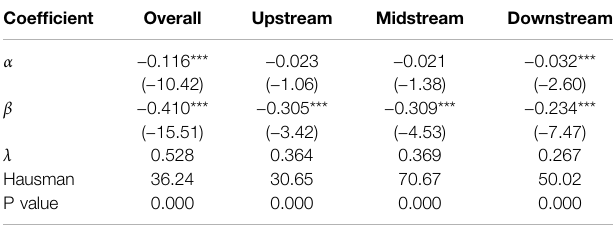
TABLE 5 | Conditional β test for ecological ef fi ciency of the Yellow River Basin. Coef fi cient